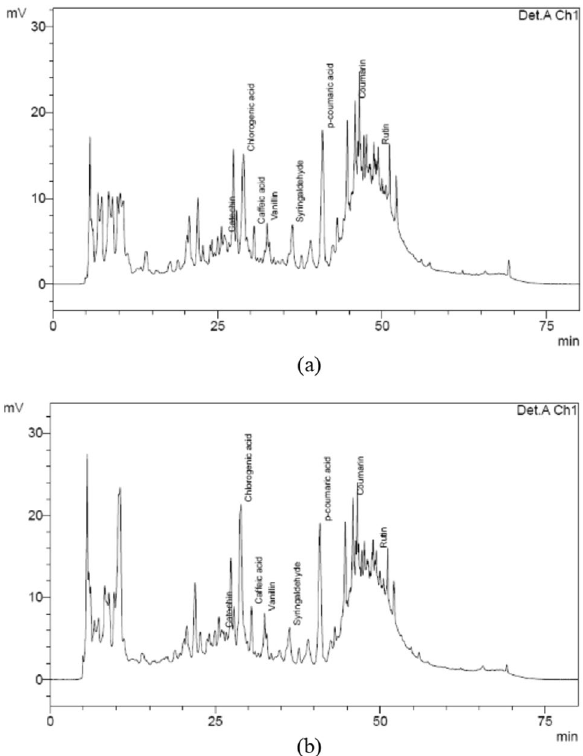
Figure 4. Chromatograms of the products obtained from the VHP sugar manufacturing stages: ( a ) syrup and ( b )